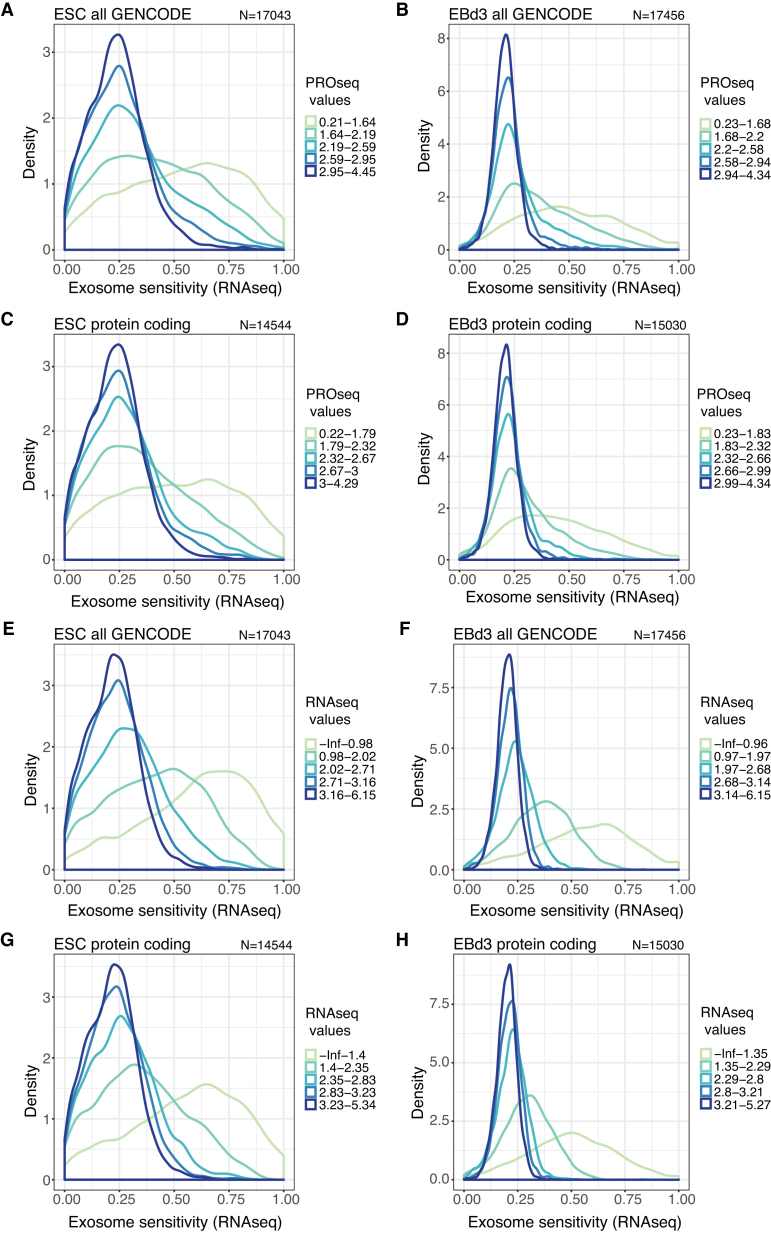
Transcripts from lowly expressed genes are preferentially exosome sensitive. (A and B) Distributions of RNA exosome sensitivities calculated from RNAseq data (see Methods) for RNAs from all GENCODE annotated genes, quintile-stratified based on their normalized PROseq values in control ESC (A) or EBd3 (B) cells. (C and D) As in (A and B) but for RNAs from GENCODE-annotated protein-coding genes only. (E–H) Equivalent to panels (A–D) but with quintile-stratification based on normalized RNAseq values in the respective control samples. For all plots, the number of genes/RNAs (N) included is indicated above each panel. Quintiles are defined by the thresholds shown in the legends to the right of plots.